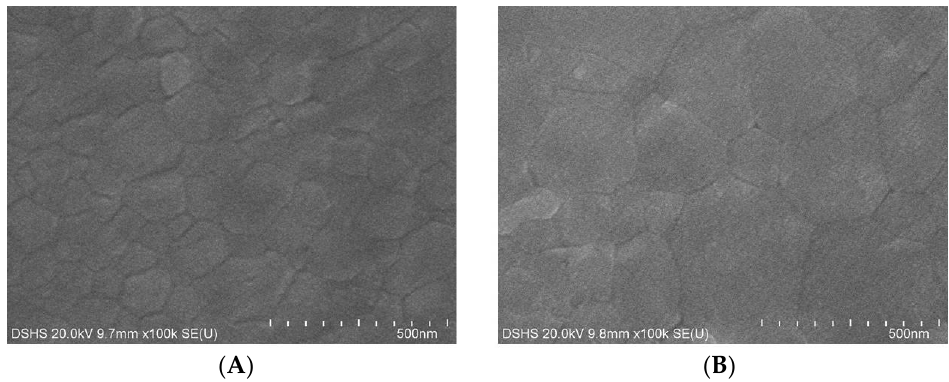
Figure 4. Scanning electron microscopic (SEM) images of MAPbI 3 perovskite films made by using ( A ) different commercial PbI 2 (from Alfa Aesar, product # 12,724 Lot # U14E066) and ( B ) the same commercial PbI 2 from Alfa Aesar but with the additional hydrothermal process.